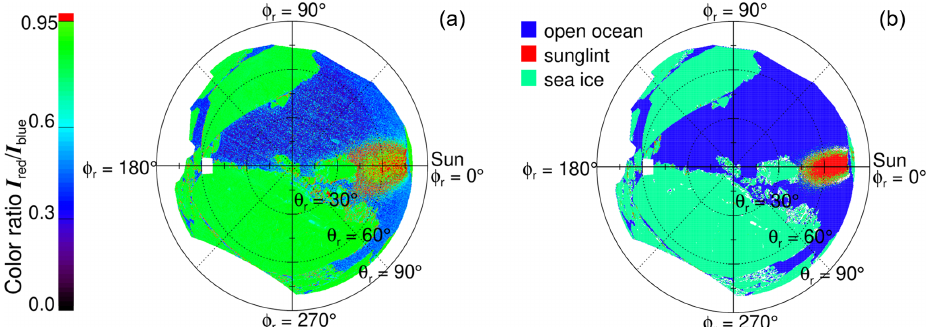
Figure 3. (a) Color ratio of an exemplary scene (same scene as in Fig. 1d). The area identified as sunglint (above the color ratio threshold c = 0 . 95) is highlighted in red. (b) Allocation of the pixels to sea ice (turquoise), open ocean (blue), or the sunglint area of open ocean (red) applying the sea ice mask illustrated in Fig. 4.